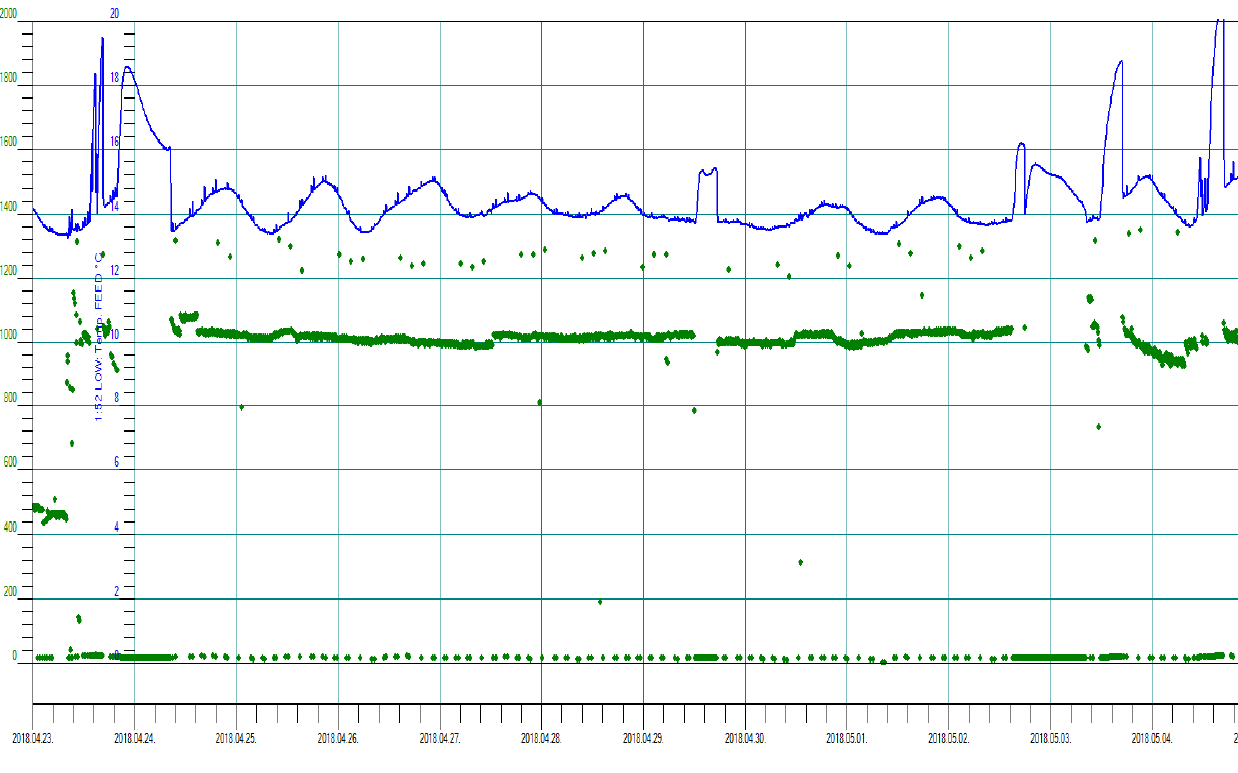
Figure A7. Flow and temperature.